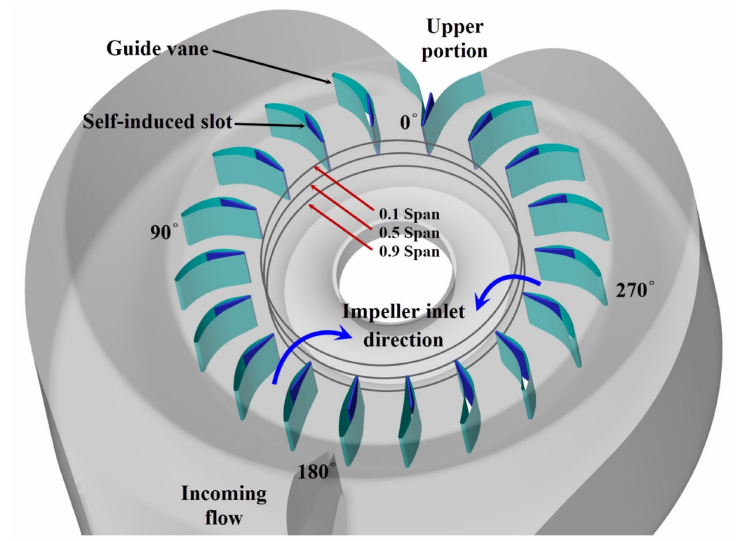
Figure 9. The locations of monitor